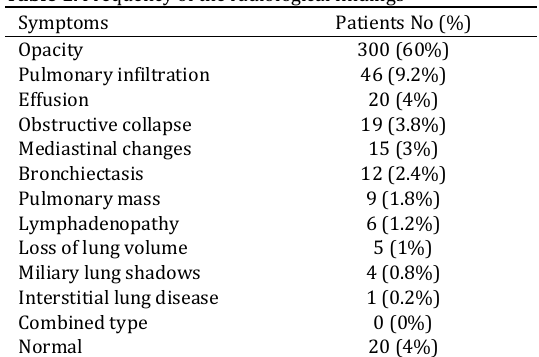
Table 1. Frequency of the radiological findings Symptoms Patients No (%) Opacity 300 (60%) Pulmonary infiltration